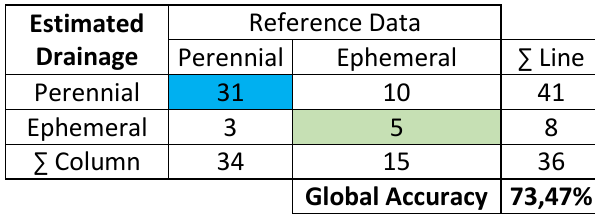
Table 8 – Accuracy Assessment of Estimated Drainage in